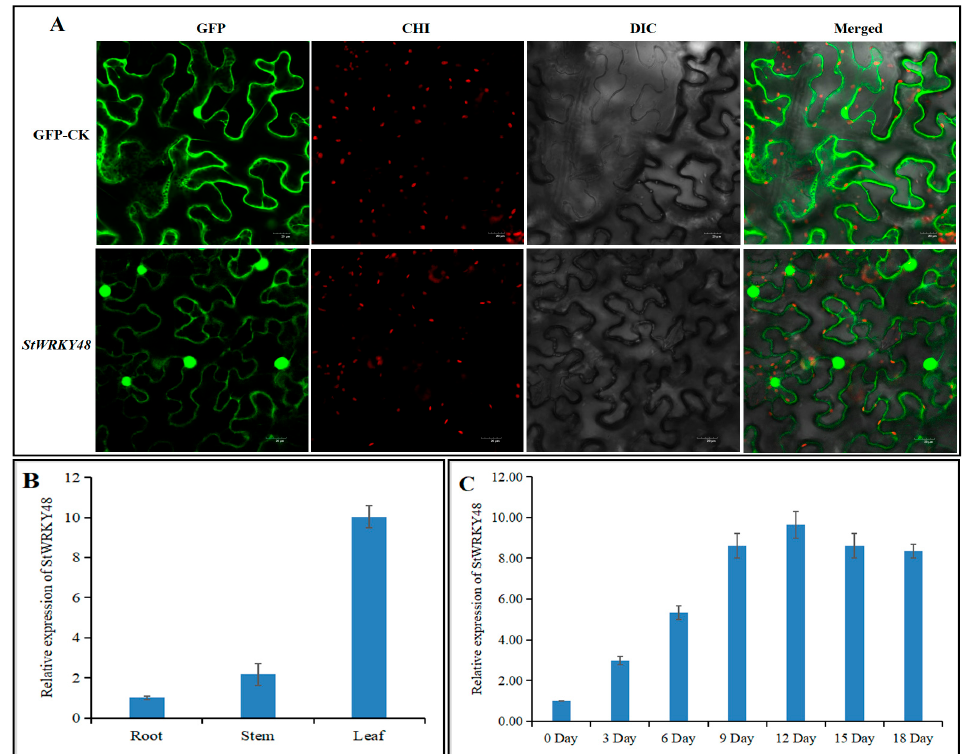
Figure 7. Subcellular localization, tissue-specific, and drought stress expression profiles of StWRKY48 . ( A ) Subcellular localization of StWRKY48-GFP and GFP genes, 35S::StWRKY48-GFP and 35S::GFP control vectors were transiently expressed in tobacco leaf. ( B ) Expressional analysis of StWRKY48 in the root, stem, and leaf of potato variety “Atlantic”. ( C ) RT-qPCR analyses of StWRKY48 expression profiles in response to drought stress in potato variety “Atlantic” leaves.